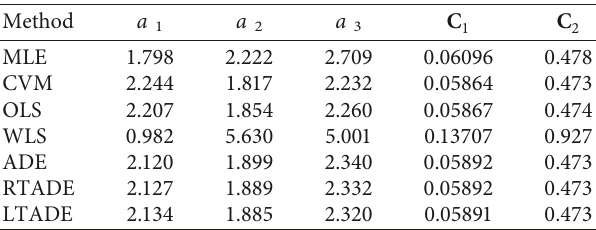
Table 14: Comparing estimation methods using breaking stress data.